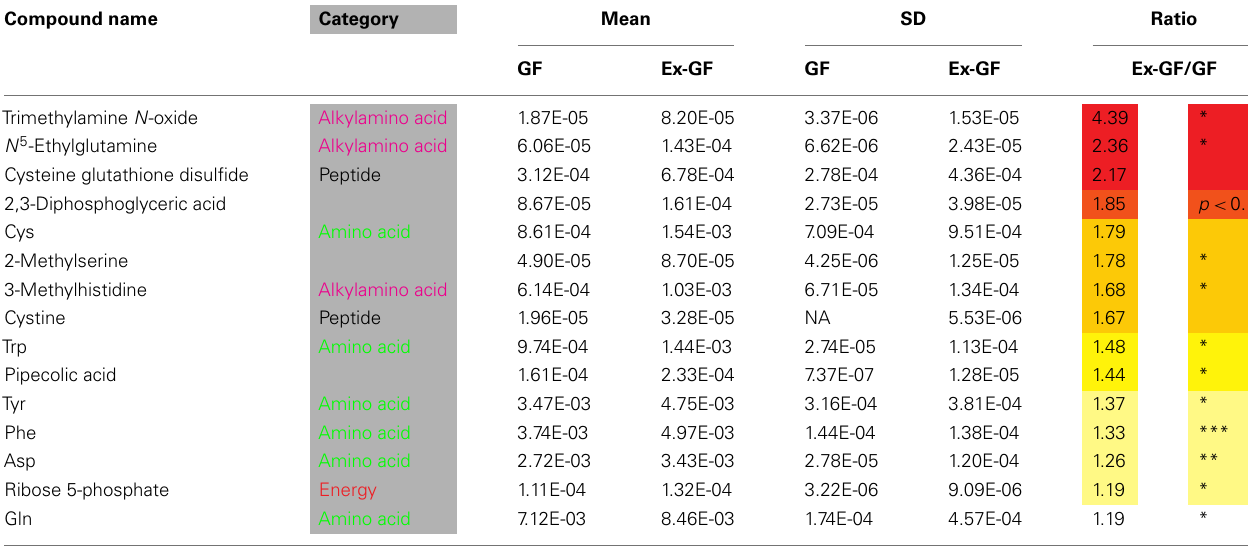
Table 1 | Metabolites whose concentrations were higher in the cerebral metabolome of Ex-GF mice than in that of GF